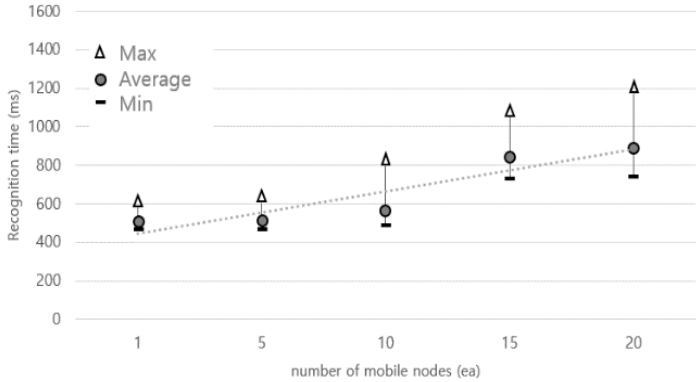
Figure 10. Recognition speed as mobile devices increase.